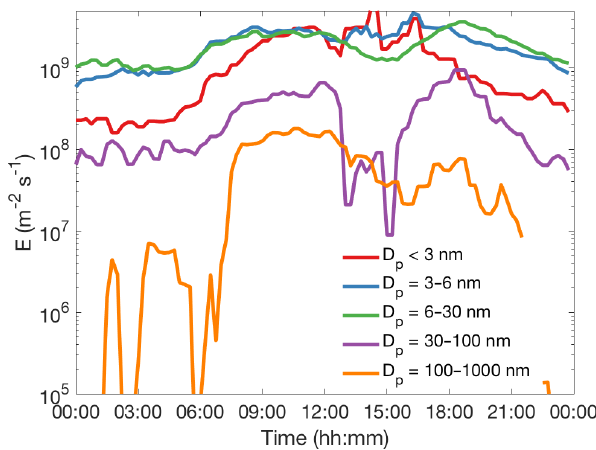
Figure A2. Average diurnal cycles of particle number emissions into different size ranges on non-NPF event